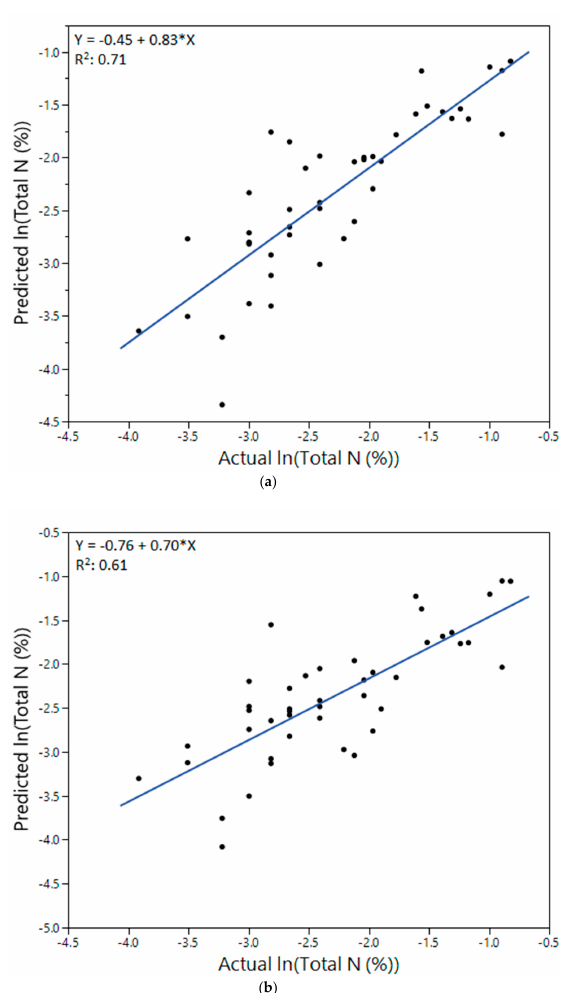
Figure 3. Plots of predicted lnTN (%) versus actual lnTN (%) for validation data sets for dry soil samples of all soil orders using ( a ) models which included depth and color variables ( p -value < 0.001), and ( b ) models which included only color variables as predictors ( p -value <